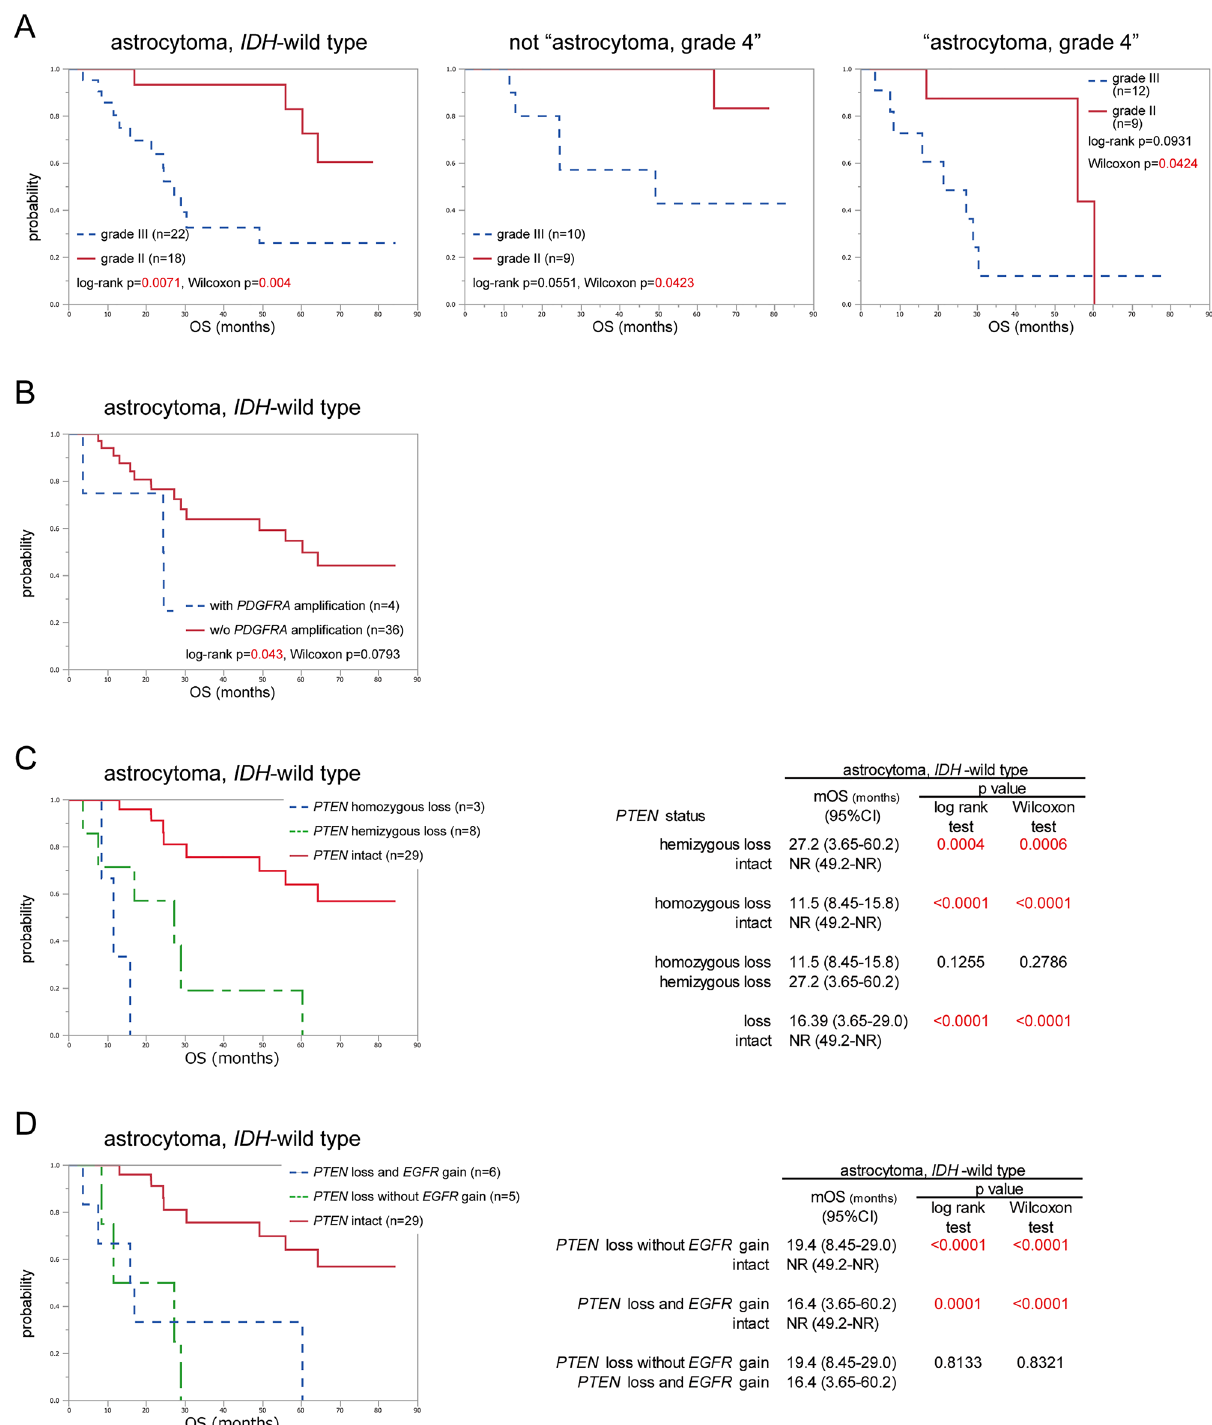
Figure 3. Survival analysis of 40 patients whose tumours were removed at their first surgery, were shown. ( A ) The overall survival of IDH -wild type diffuse astrocytomas (grade II) and anaplastic astrocytomas (grade III) were compared in the groups of all IDH -wild type astrocytomas, “astrocytoma, grade 4” , and not-“astrocytoma, grade 4”. The overall survival was also analysed stratified by the following factors associated with factors not included in cIMPACT-NOW update 3 criteria; ( B ) PDGFR amplification, ( C ) PTEN status (intact, hemizygous loss, or homozygous loss), and ( D ) the combination status of PTEN loss and EGFR gain. The p values were calculated log-rank test and Wilcoxon test, and p < 0.05 was shown with red